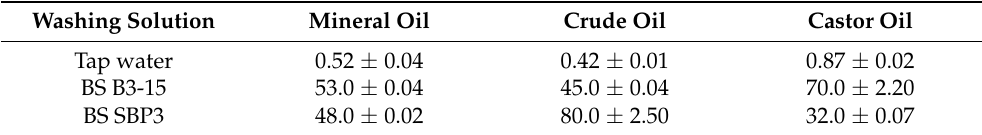
Table 6. The removal rate (%) of mineral, crude, and castor oil from cotton sections by BS solution (1 g L − 1 ) obtained from B3-15 and SBP3 strains. Data are expressed as averages and standard deviations (n =